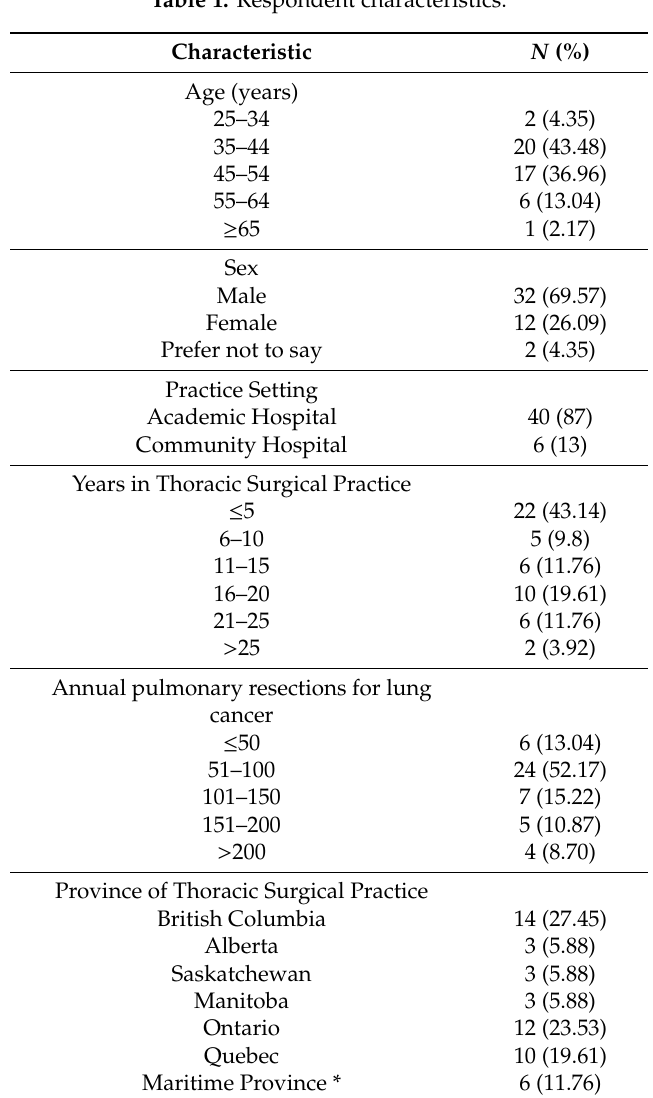
Table 1. Respondent